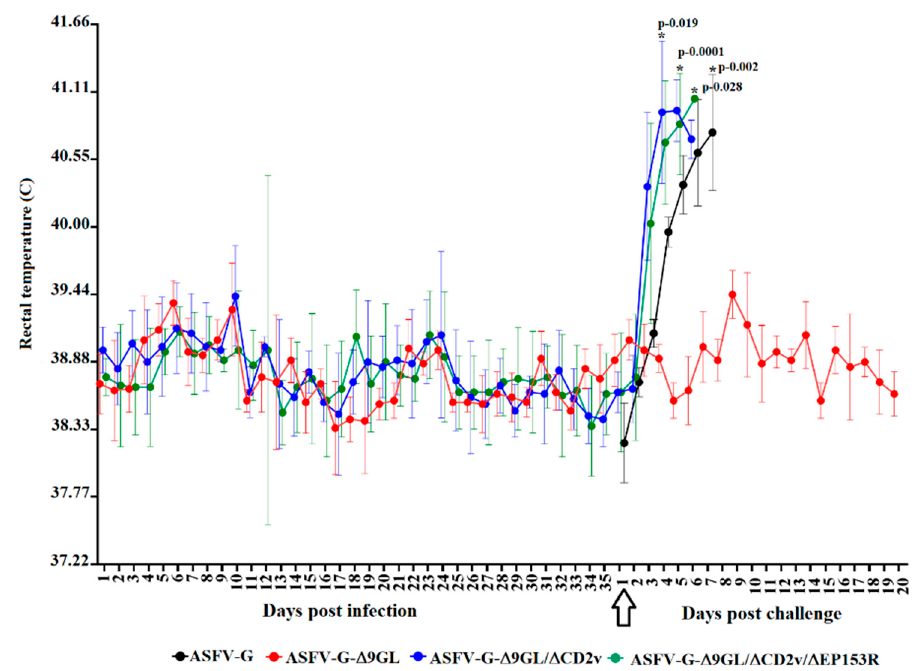
Figure 3. Evolution of body temperature in the animals (4 animals / group) intramuscularly (IM) infected with 10 3 TCID 50 of either ASFV-G- ∆ 9GL, ASFV-G- ∆ 9GL / ∆ CD2v, or ASFV-G- ∆ 9GL / ∆ CD2v / ∆ EP153R. Pre- and post-challenge (indicated by the arrow) body temperatures, presented as average values and their SD, are shown for each of the experimental groups. Statistical significance (*) determined using the Holm–Sidak method ( α = 0.05). Each day of sample collection was analyzed individually, without assuming a consistent SD. Analysis was conducted on Graphpad Prism software version 8.2.1.